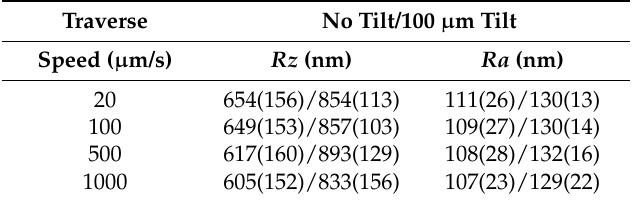
Figure 8. Measured roughness parameters for four different scanning speeds on a well-aligned roughness standard (RN6531) (square symbols) and on the same standard inclined by 100 µm (triangle symbols) (Rz: blue and Ra: green). Table 2. Measured roughness parameters for four different traverse speeds on a well-aligned roughness standard (RN6531) that is not tilted and on the same standard inclined by 100 µm ( λ c = 80 µm and λ s = 2.5 µm).